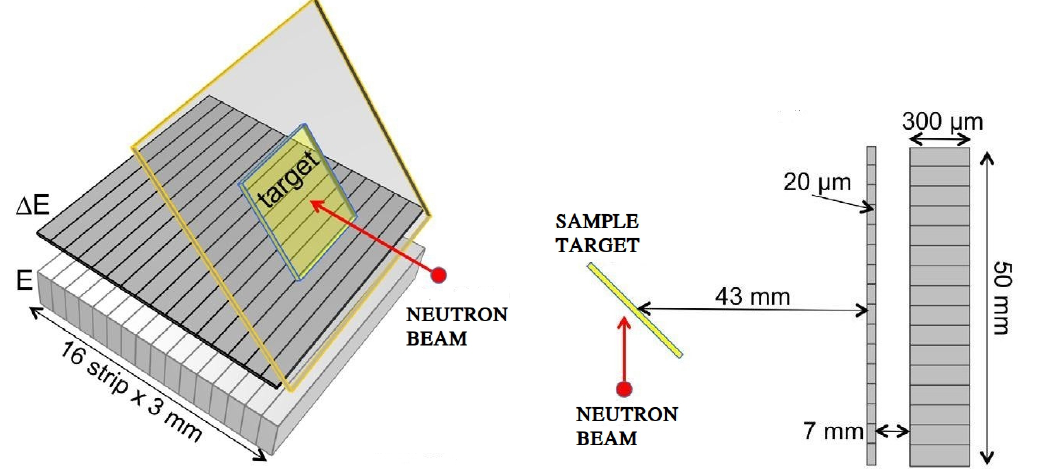
Figure 4. ( right ): 3D view of the detector setup; ( left ): profile view of the detector setup